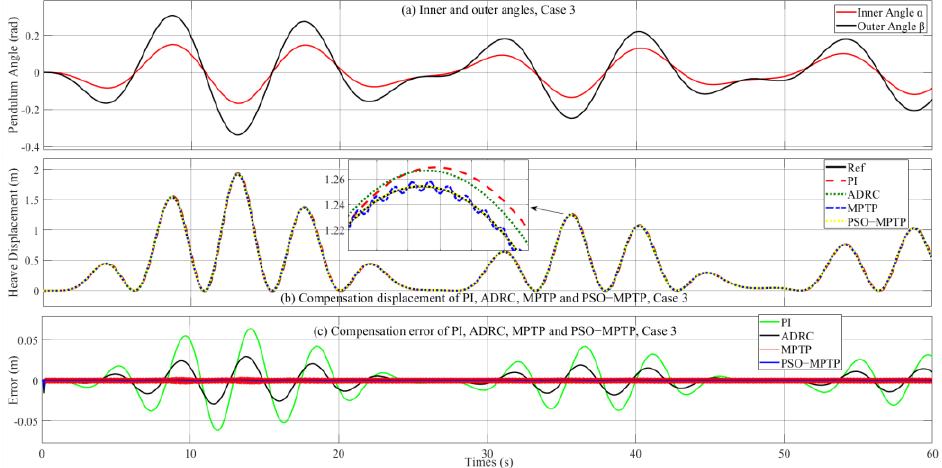
Figure 11. ( a ) Inner and outer angles, Case 3. ( b ) Compensation displacement of PI, ADRC, MPTP, and PSO − MPTP, Case 3. ( c ) Compensation error of PI, ADRC, MPTP, and PSO − MPTP, Case 3.